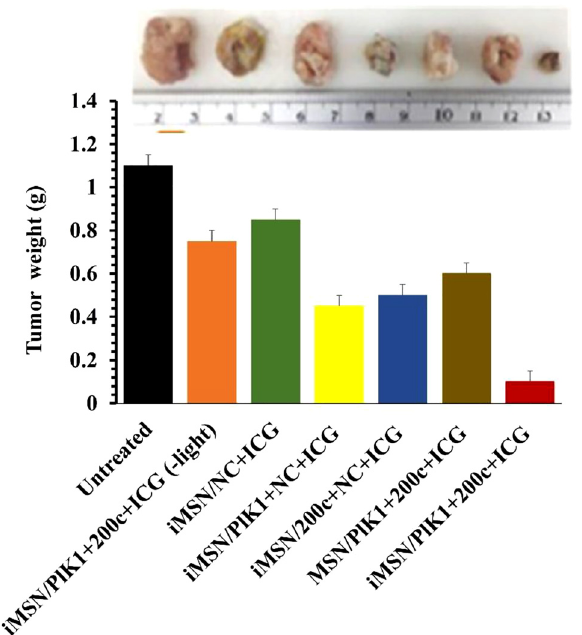
Figure20: Representativeimagesandweightoftheisolatedtumors from different groups.